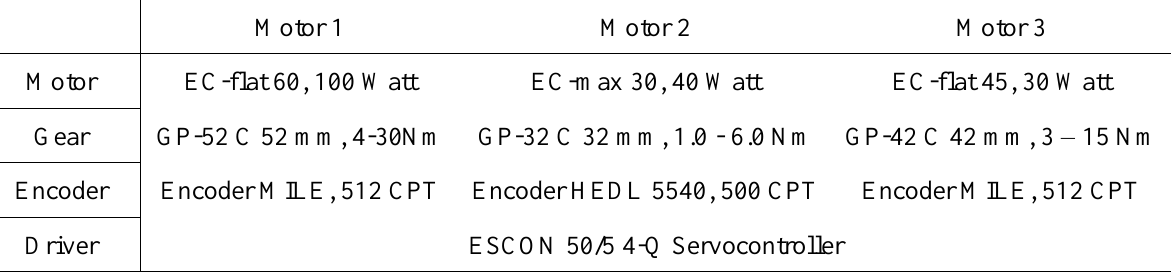
Table 3. Motor – Gear – Encoder – Driver